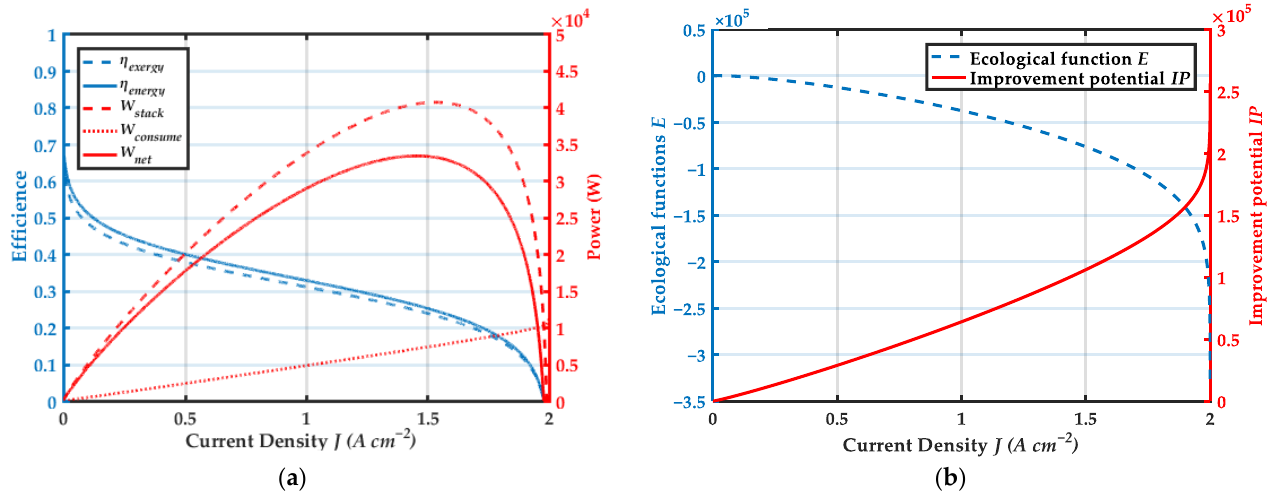
Figure 5. Variation trends of system performance with current density: ( a ) Variation trends of 𝜂 𝑒𝑛𝑒𝑟𝑔𝑦 , 𝜂 𝑒𝑥𝑒𝑟𝑔𝑦 , 𝑊 𝑠𝑡𝑎𝑐𝑘 , 𝑊 𝑐𝑜𝑚𝑠𝑢𝑚𝑒 and 𝑊 𝑛𝑒𝑡 with current density 𝐽 ; ( b ) Variation trends of ecological function 𝐸 and improvement potential 𝐼𝑃 with current density 𝐽 .